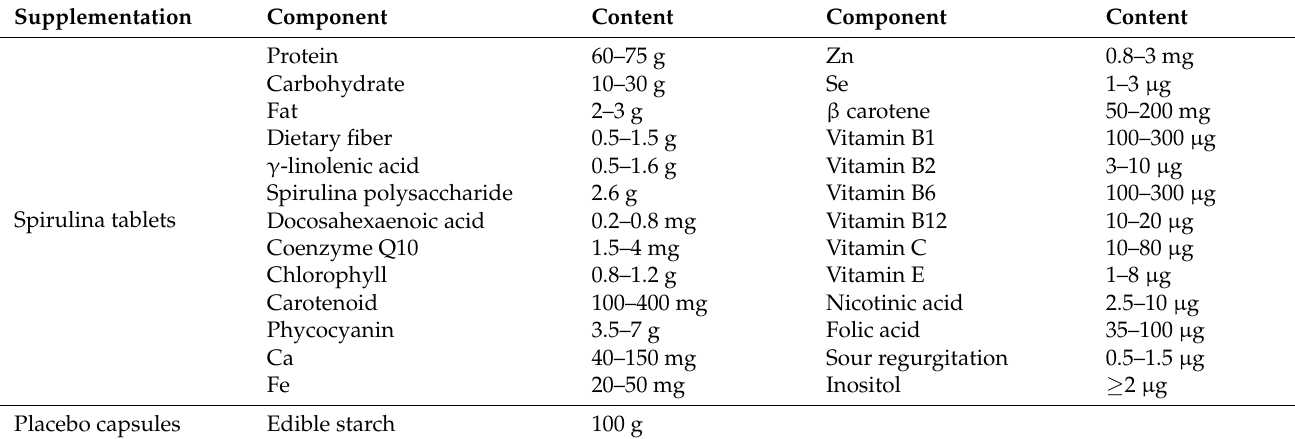
Table 2. The ingredient list of spirulina and placebo (per 100 g).